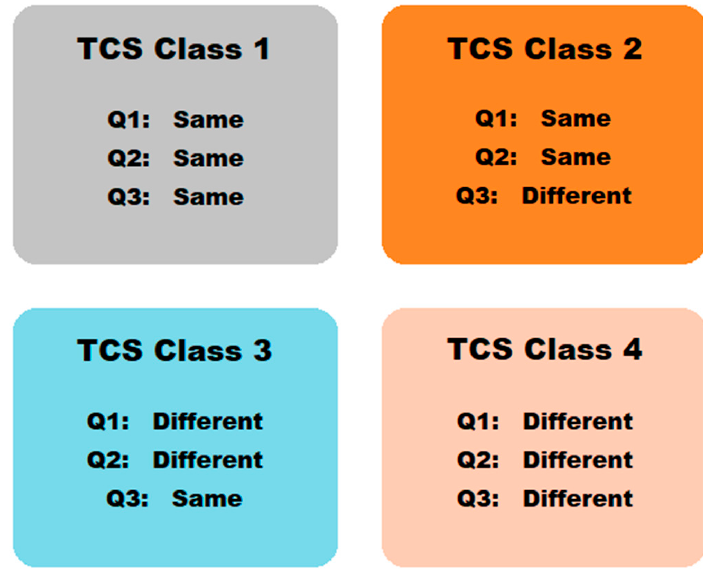
Figure 2. Topical Drug Classi fi cation System (TCS) [22].